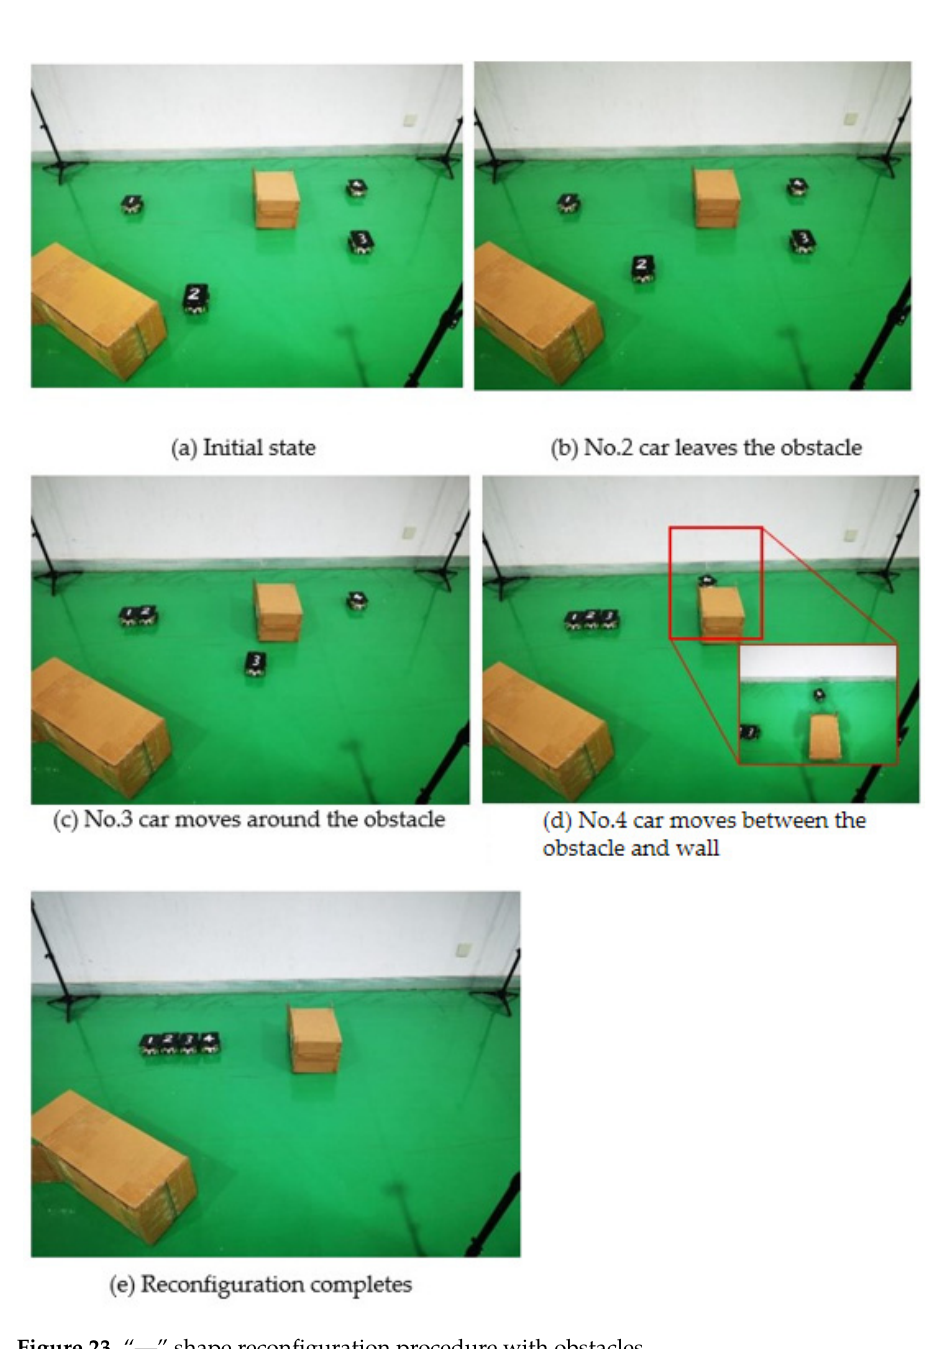
Figure 23. “—” shape reconfiguration procedure with obstacles.